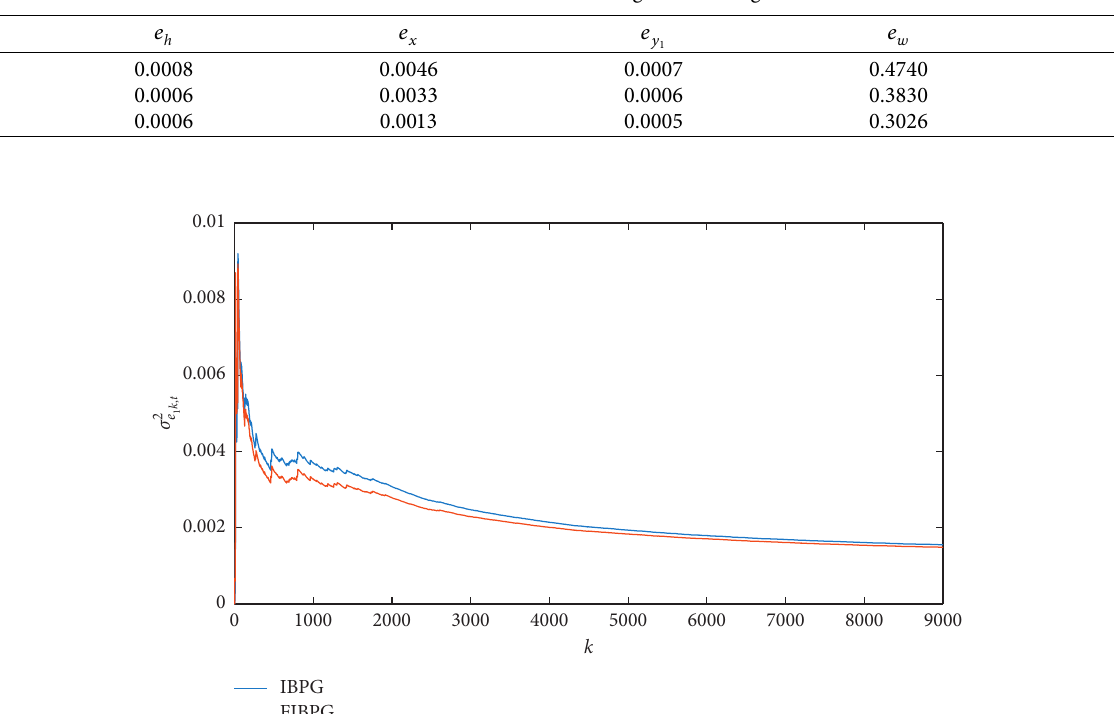
Table 5: Estimation errors for the FSOEAHW model using MIIBPG algorithm with L � 2, 5, and 7.